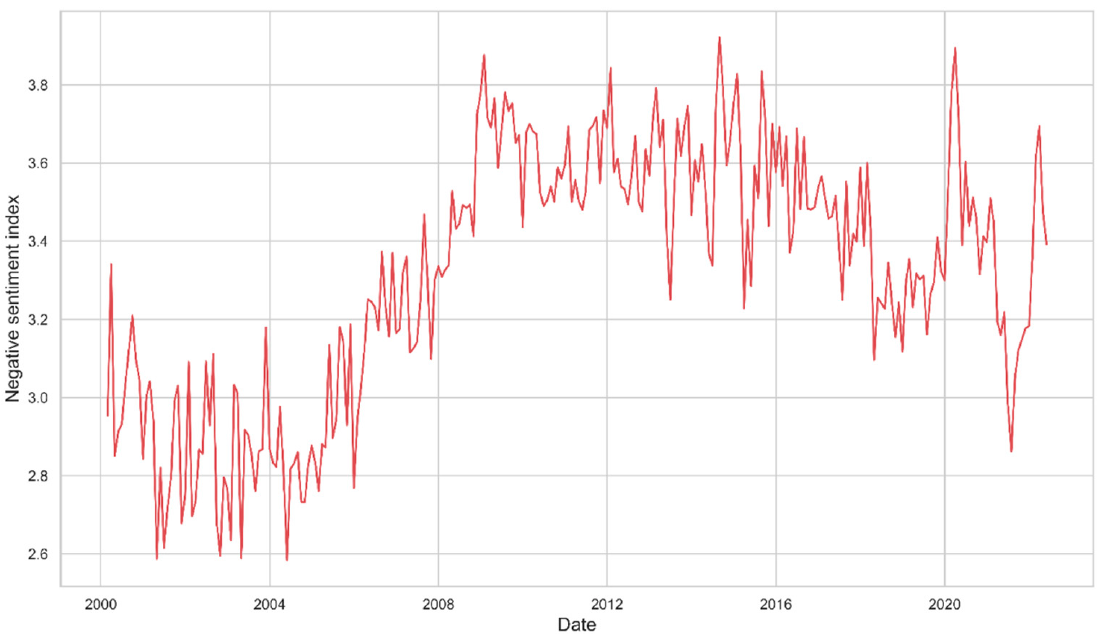
Figure 7. Graphic representation of negative sentiment analysis for the business news category using news article titles and article lead information.